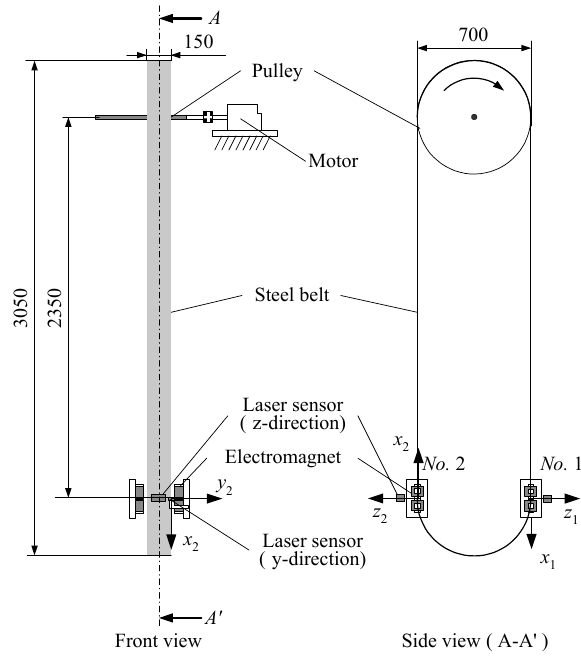
Figure 1. Non-contact guide system.